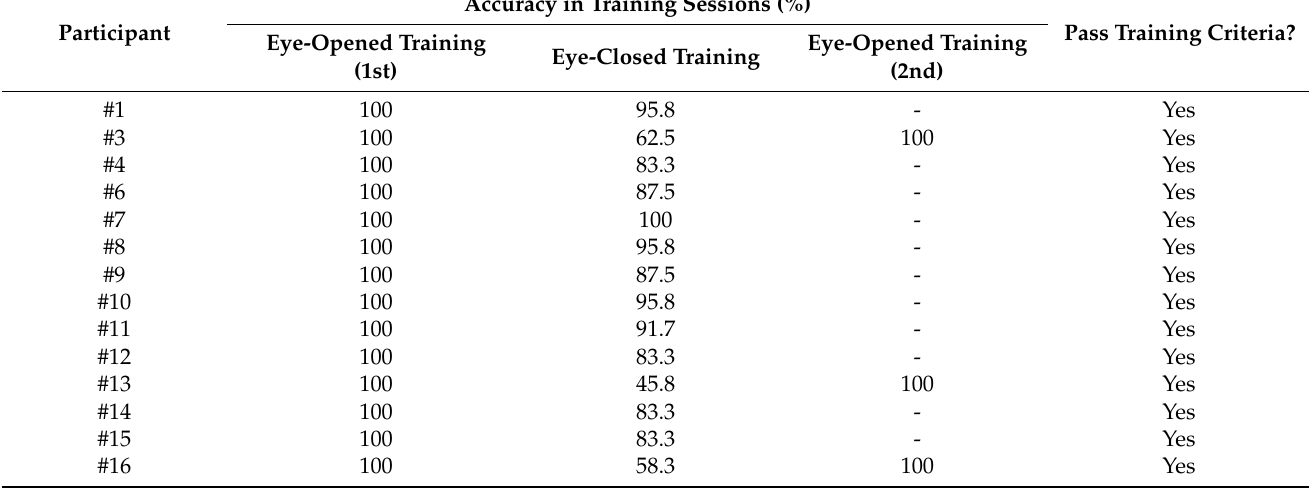
Table 2. Accuracy in training